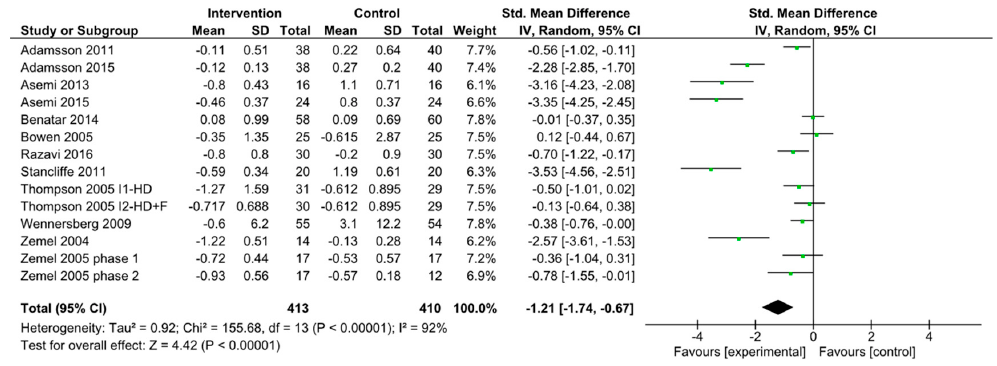
Figure 2. Forest plot of randomized clinical trials of dairy intake and HOMA-IR. Abbreviations: F, fiber; HD, high dairy diet.